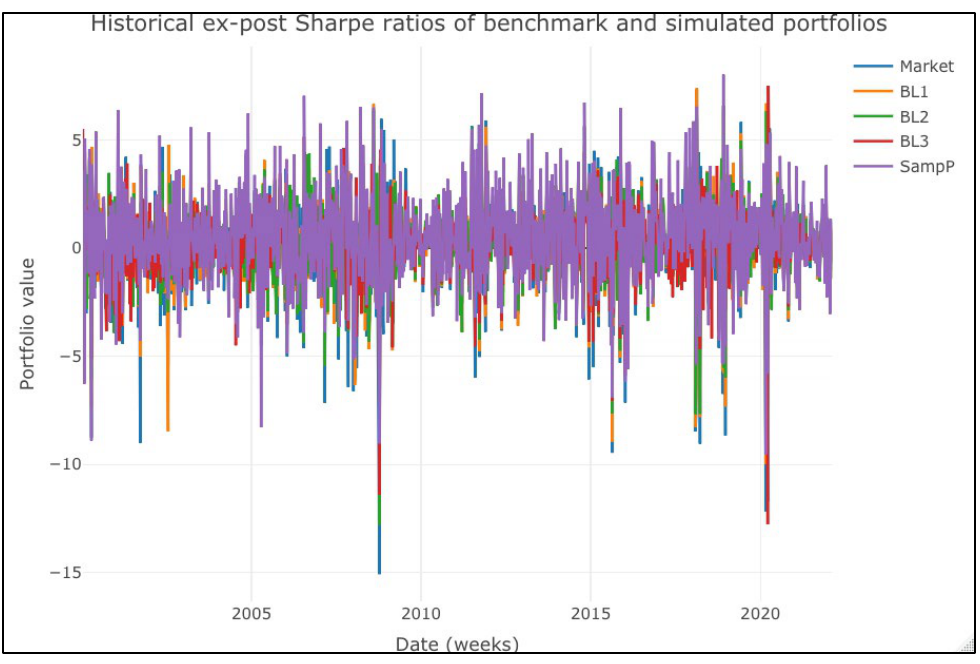
Figure 5. Simulated portfolios’ historical ex-post Sharpe ratios. Table 5. One-way ANOVA test of the simulated portfolios’ ex-ante Sharpe.